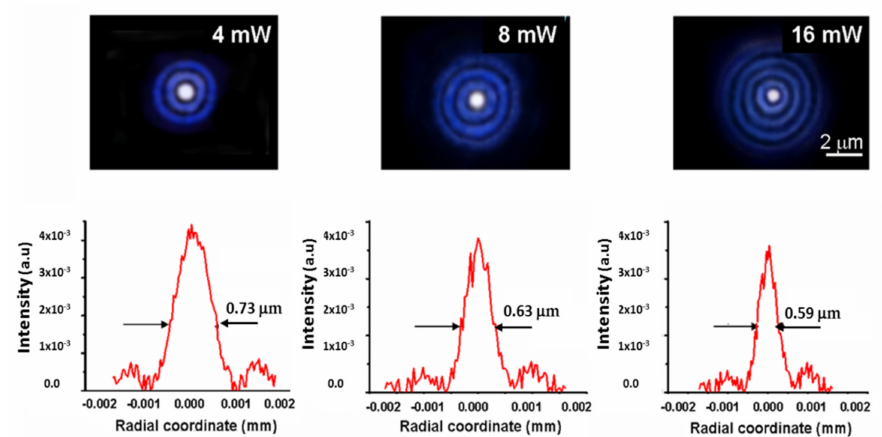
Figure 11. Upper part: Photos of the focal LFRB spots magnified 2200 times at different heating powers at λ 2 = 405 nm. The scale bar represents the actual dimensions of the focal cross-section. Lower part: Corresponding measured diametric light distributions.